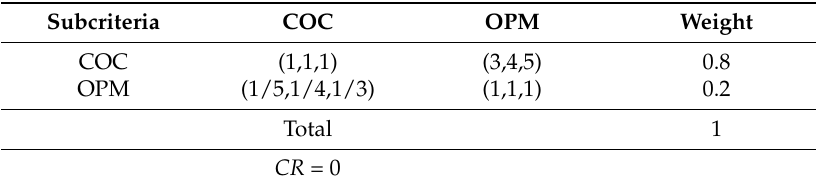
Table A18. Comparison matrix for POD.